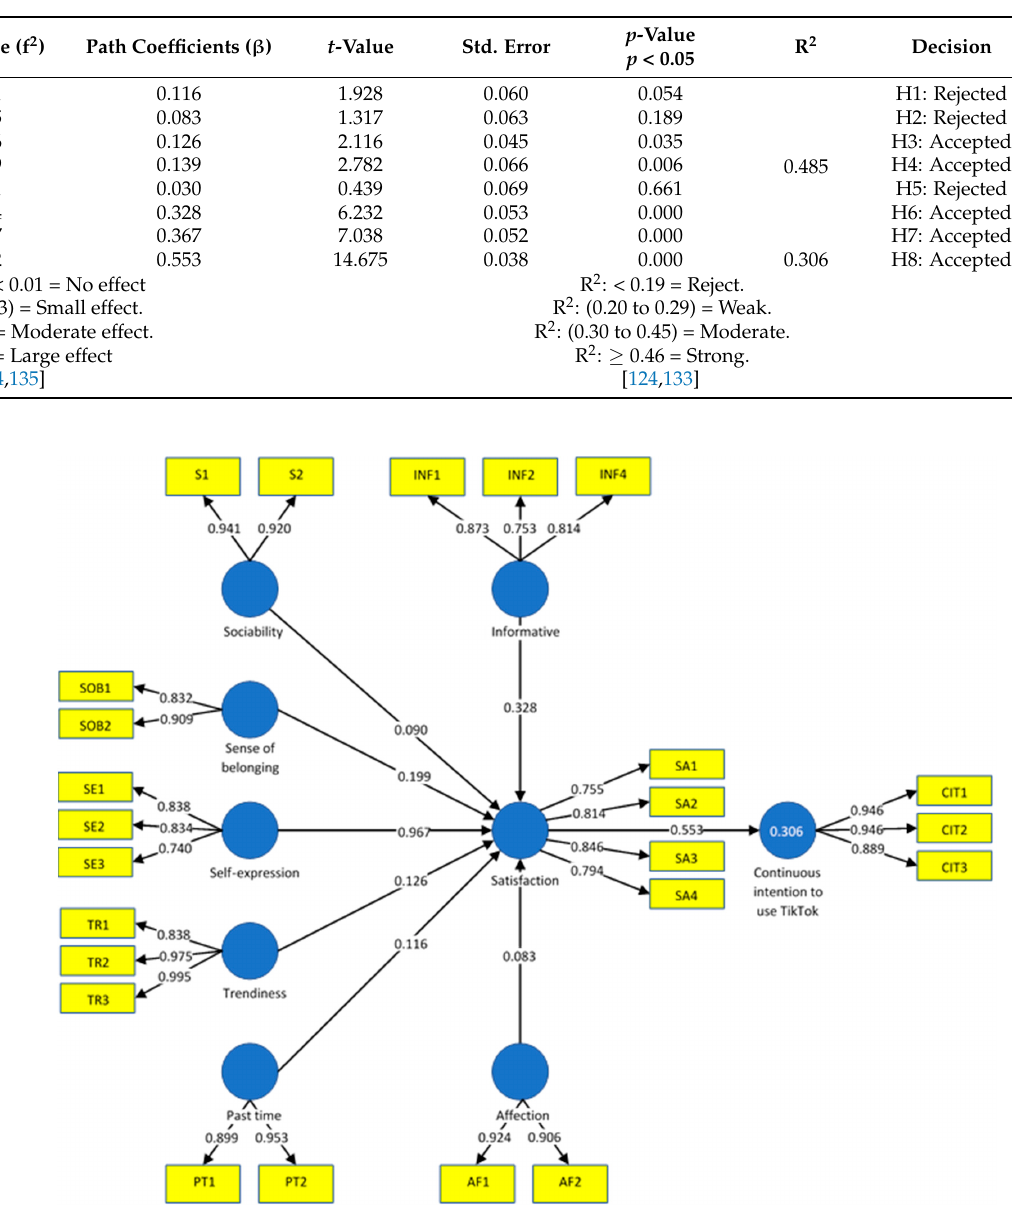
Figure 2. The Study ’ s Model Testing